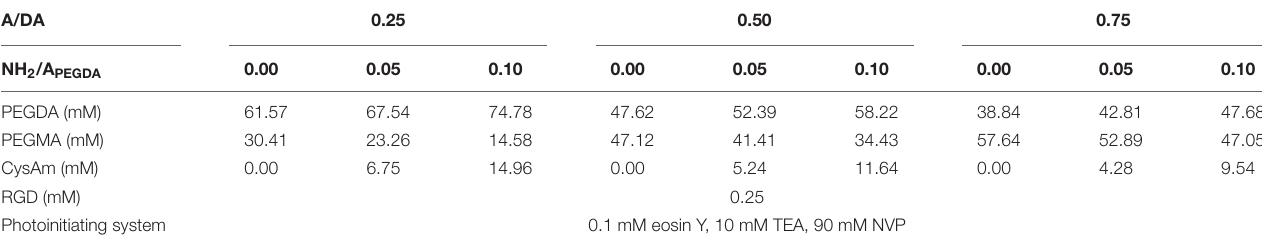
TABLE 1 | List of components and their concentrations used to prepare the precursor solutions for the investigated